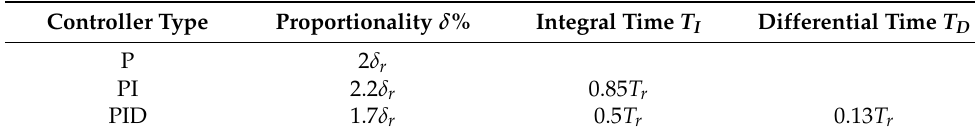
Table 4. Critical Proportionality Method for Setting PID